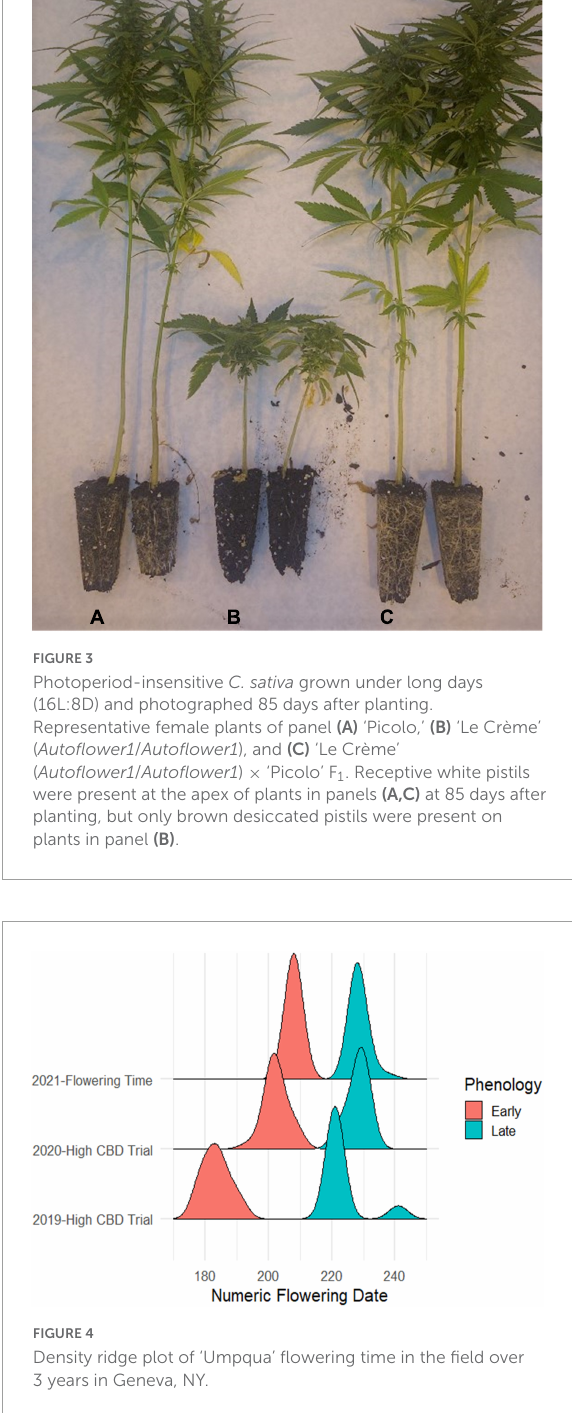
38.67–39.36, and 59.8–59.9 Mb. A total of 45 genes are annotated within these regions, of which the strongest candidate gene for Early1 based on molecular function is